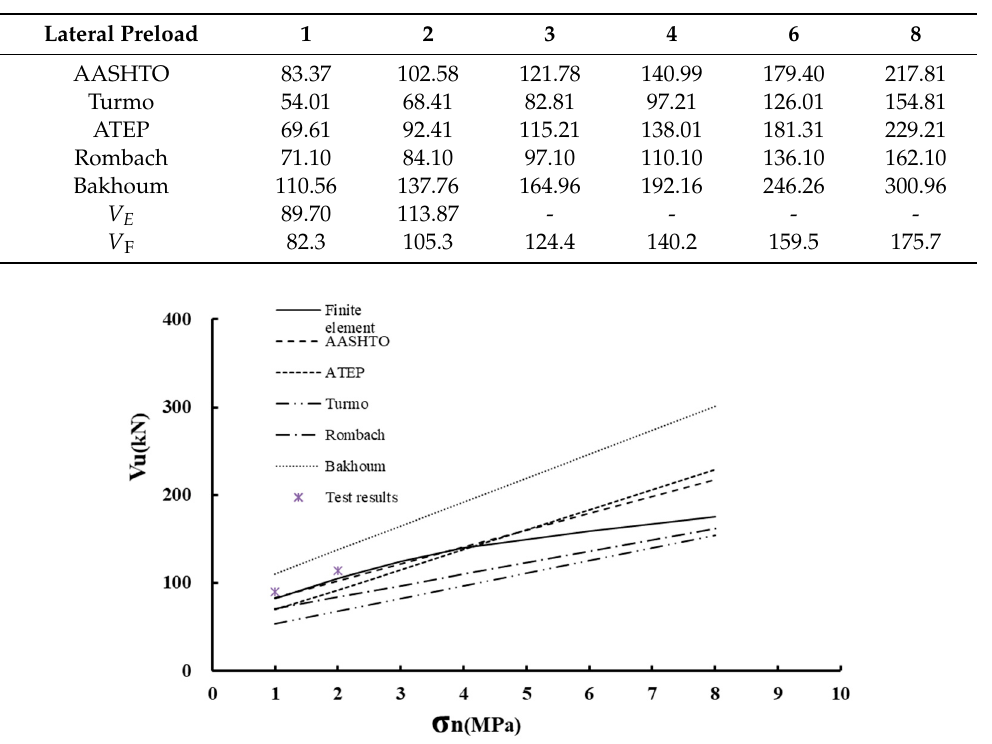
Table 2. Calculation results of various formulas under different lateral prestress.